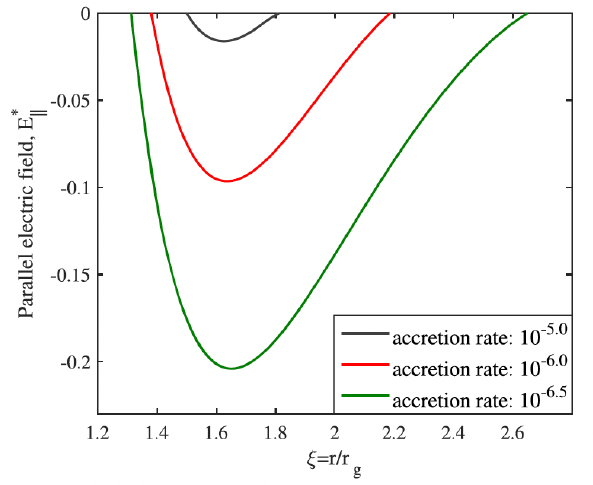
Figure 12. Characteristic gap evolution for a rotating supermassive black hole of mass 10 9 M (cid:12) that accretes in a radiatively inefficient mode. The curves show the radial distribution of the parallel electric field component for different accretion rate. The gap width and voltage drop increase as the accretion rate drops because pair creation of energetic photons with the soft photon field becomes less efficient. Results like these can be used to evaluate the gap properties and prospects for UHECR acceleration for a particular source of interest. From ref. [115].